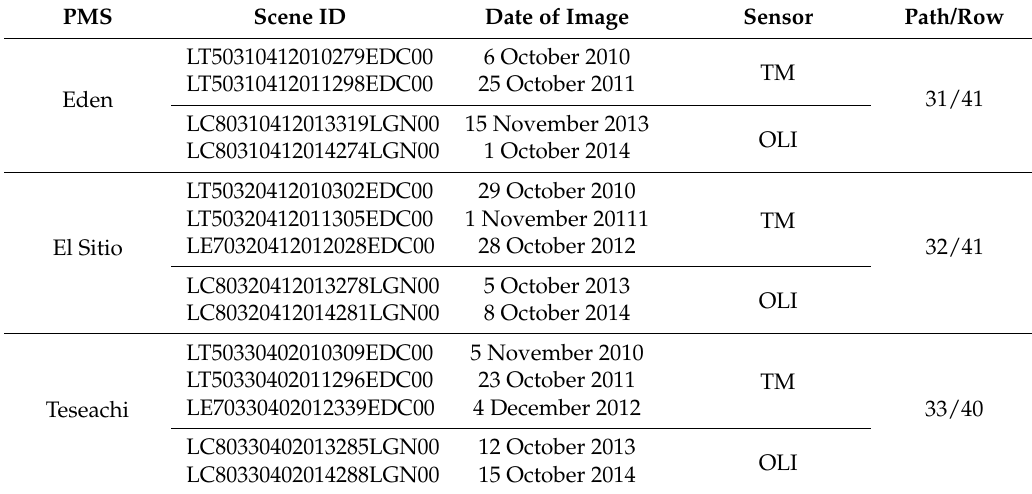
Table 1. Characteristics of Landsat Thematic Mapper (TM) and Operational Land Imager (OLI) scenes used in the